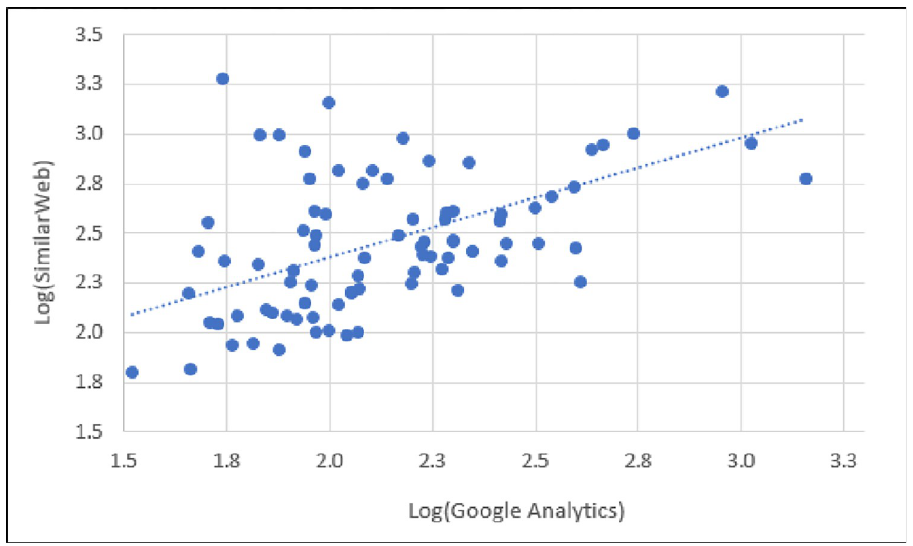
Fig 5. Scatter plot of average session duration reported by Google Analytics and SimilarWeb showing moderate, positive, linear correlation.